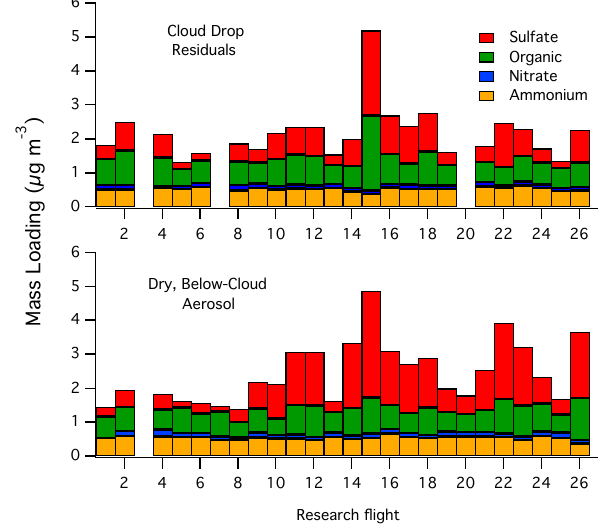
Fig. 2. Bulk AMS species measured in cloud drop residuals (top panel) and dry, below-cloud aerosol (bottom panel) over the course of the study. Only organic and sulfate vary significantly each day (variance of organic = 0.04, sulfate = 0.6 in below-cloud aerosol). Ammonium and nitrate exhibit variances that are at most 0.5% of the variance of